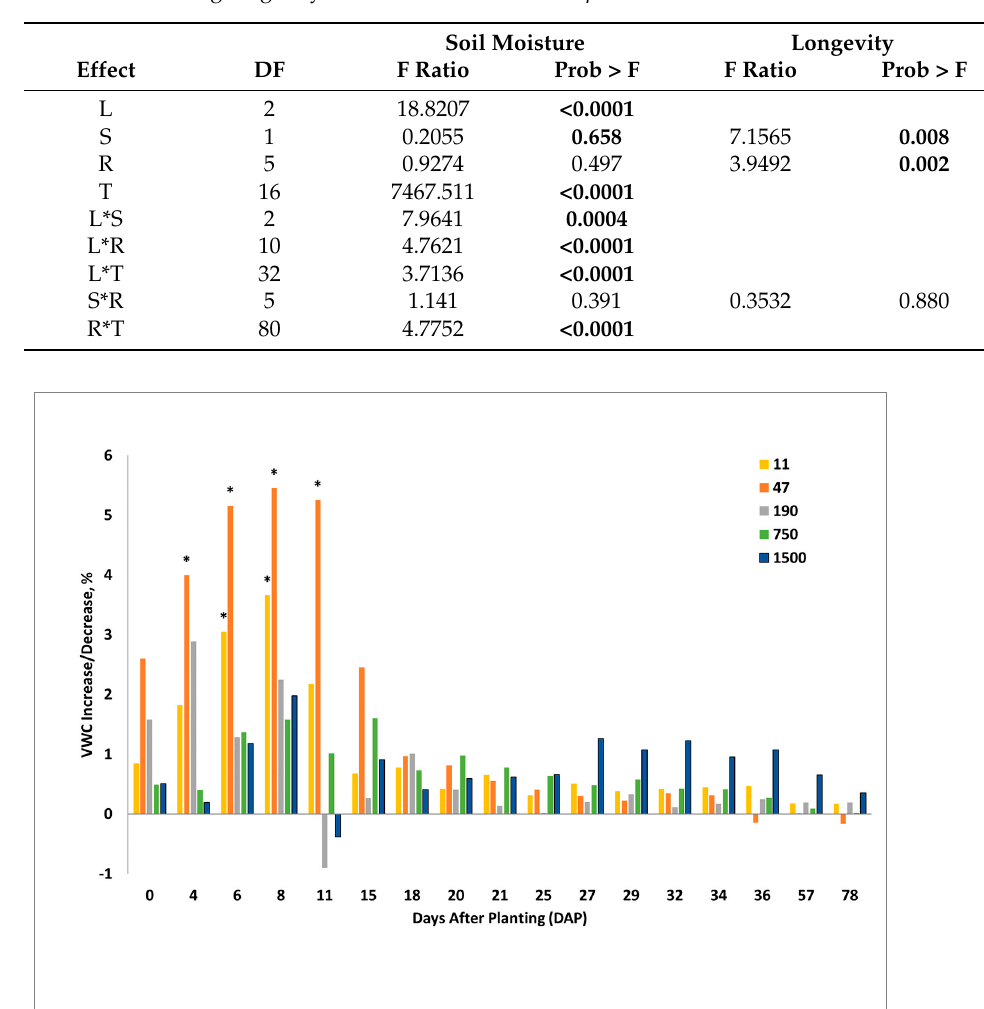
Figure 7. Volumetric Water Content (VWC) different from the control as a function of a superabsorbent polymer (SAP) rate and time relative to an untreated control in a glasshouse study with bottlebrush squirreltail and Siberian wheatgrass seeded at NRCS recommended rates. Data are averaged across both species. The SAP rates of 11, 47, 190, 750, or 1500 kg ha − 1 were placed in a band at a depth of 8 cm perpendicular to the seed rows. Following the SAP treatment, the soil was saturated once and then dried down naturally over the time of the study. Bars with “*” indicate statistical significance relative to the control within that day ( p = 0.05).